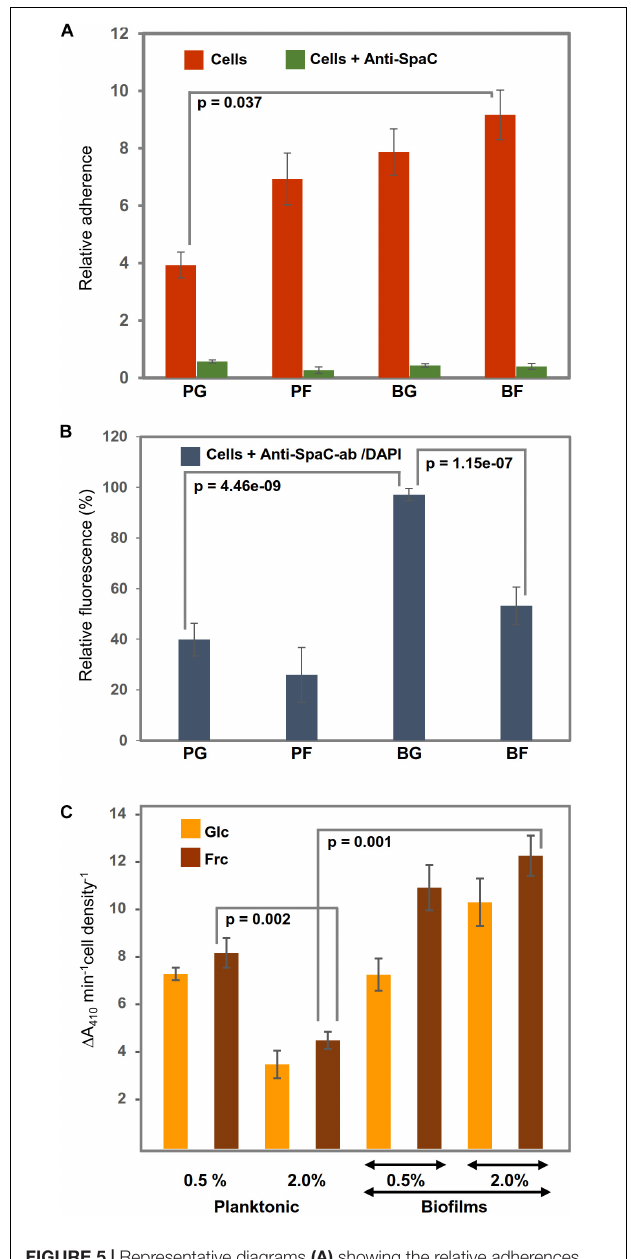
FIGURE 5 | Representative diagrams (A) showing the relative adherences (average adhesion percentage of the added bacteria) of planktonic (PC) and biofilm GG (BC) cells grown on frc and glc to porcine mucus and (B) illustrating the abundance of the SpaC pilin subunit on the cells treated first with anti-SpaC-antibody and then Alexa-488-conjugated goat anti-rabbit IgG and/or the DAPI counterstain. (C) The surface-associated aminopeptidase activity (PepC and PepN) of the planktonic and biofilm cells was assessed using 1 mM Leu-pNA. Significant differences are indicated with lines. The error bars indicate SD for two or more biological replicates, each with several technical